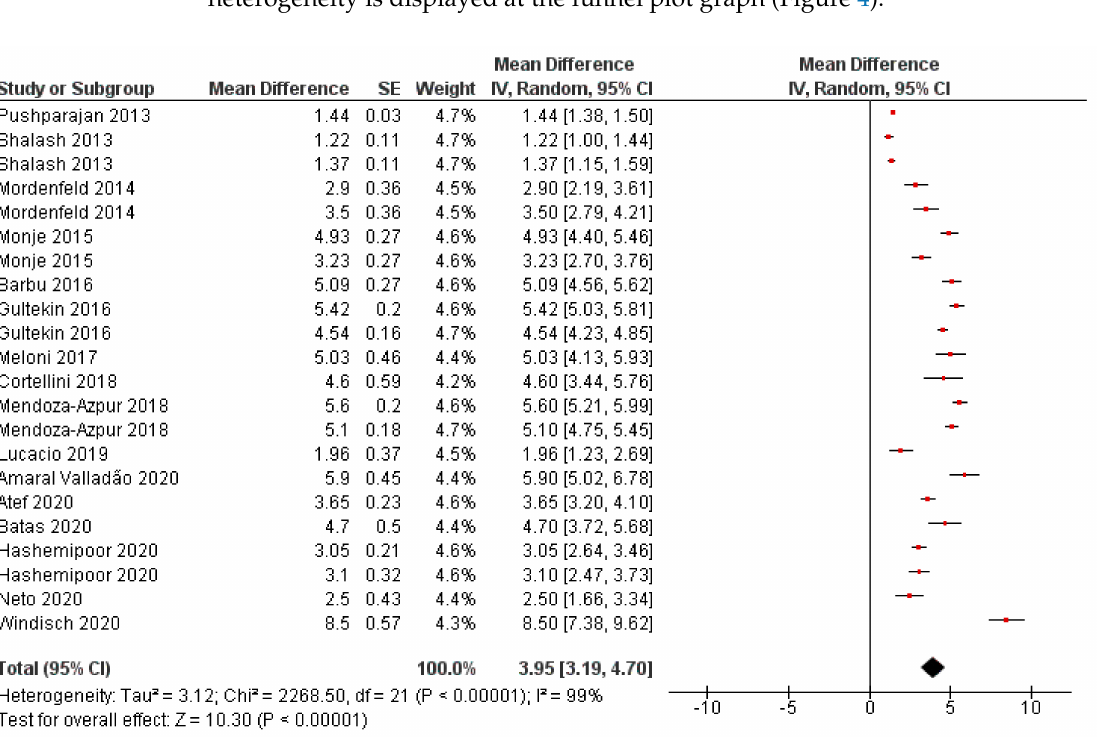
Figure 3. Horizontal bone gain forest plot. Weighted mean is presented at CI 95%. Heterogeneity was determined using Higgins (I2). A random-effects model was applied. Statistical significance was set at